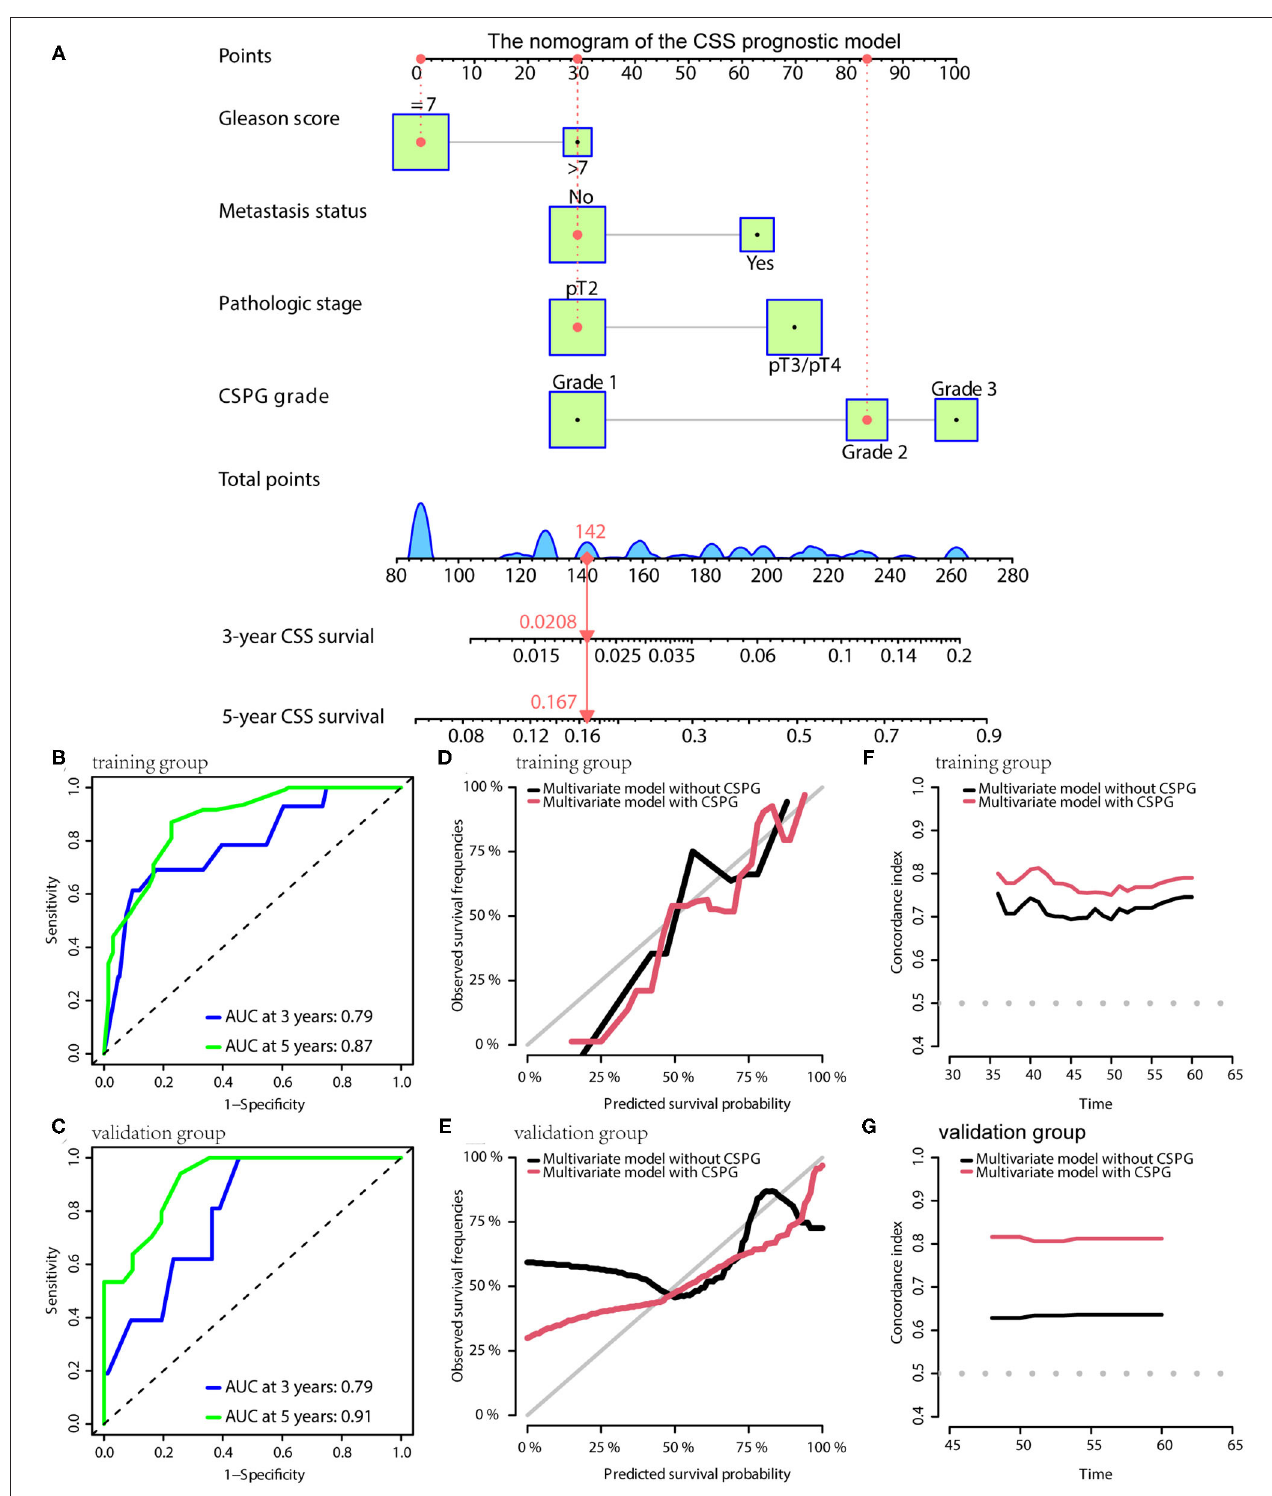
FIGURE 6 | The CSS prognostic model possesses the accuracy and robustness. (A) Nomogram of the CSS prognostic model with information of one patient as an example. (B) Time-dependent receiver operating characteristic (tdROC) curves show the model has a good predictive accuracy at 3 and 5 years in the training group (B) and in the validation group (C) . The calibration curves indicate that the model using a combined cysteine rich secretory protein 3 (CRISP3) and serine peptidase inhibitor Kazal type 1 (SPINK1) prognostic grade (CSPG) predicts prognosis more accurately in the training group (D) and in the validation group (E) . The line chart shows the model using a CSPG has higher C-index values in the training group (F) and in the validation group (G) . CSS, cancer-specific survival.